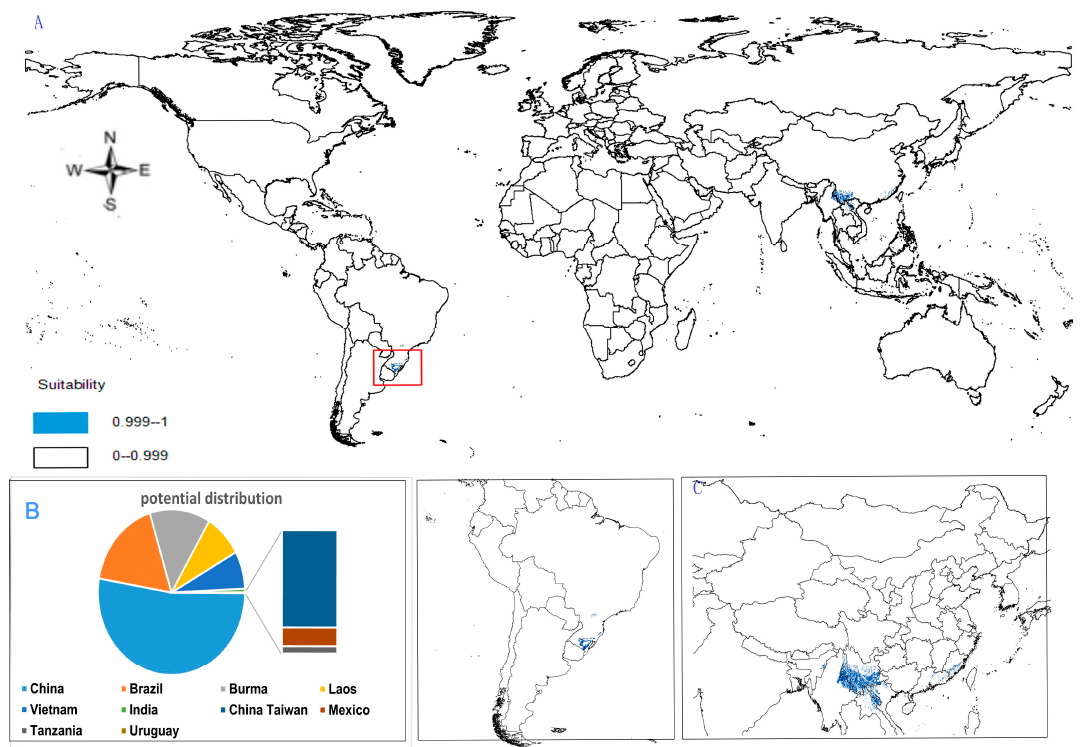
Figure 6. Spatial distribution map of potential suitable distribution for P. stipuleanatus by GMPGIS. ( A ) Global potential distribution; ( B ) Global rank of the potential distribution area; ( C ) Chinese potential distribution.